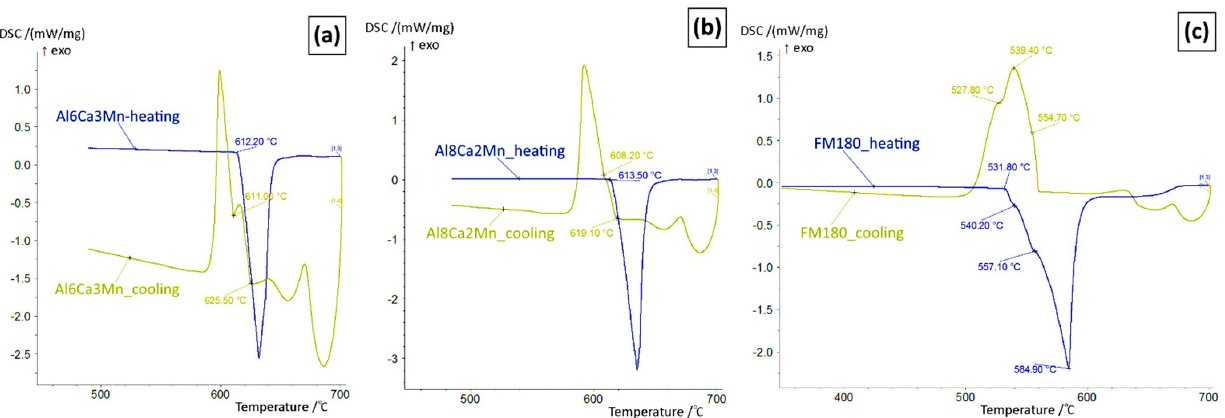
Figure 10. Results of the differential thermal analysis and direct thermal analysis on the: ( a ) Al-6Ca-3Mn; ( b ) Al-8Ca-2Mn; ( c ) FM180 alloys .